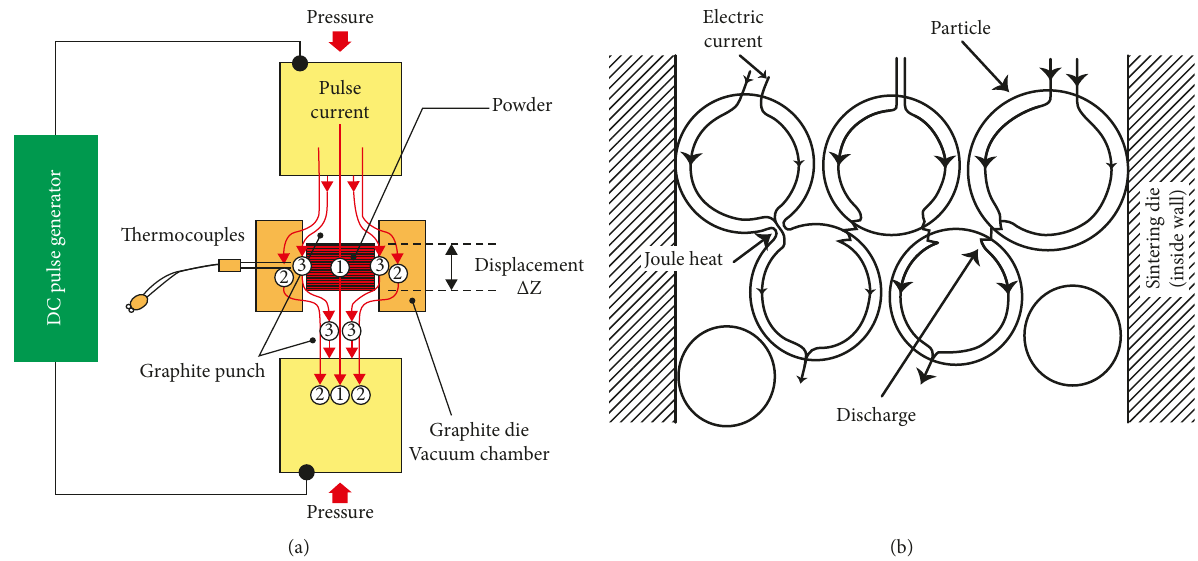
Figure 10: Pulse current flow through (a) the spark plasma sintering (SPS) machine and (b) the powder particles, as adopted from